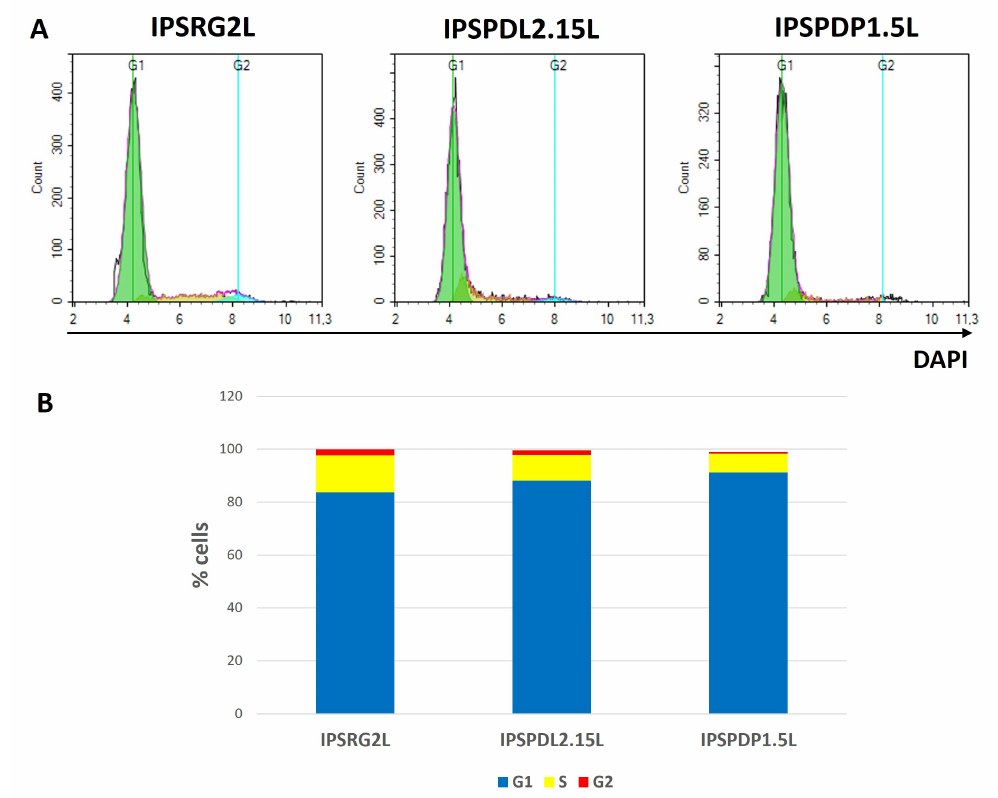
Figure 6. Cell cycle analysis by flow cytometry. ( A )—distribution of cells by phases of the cell cycle for neurons on day 65 of differentiation generated from IPSRG2L line obtained from a healthy donor (left), from IPSPDL2.15L line obtained from PD patient with mutation in PARK8 gene (middle), from IPSPDP1.5L line obtained from PD patient with mutation in PARK2 gene (right). ( B )—the histogram shows the proportion of cells in G1, S and G2 phases of the cell cycle. Statistical data are shown in Table